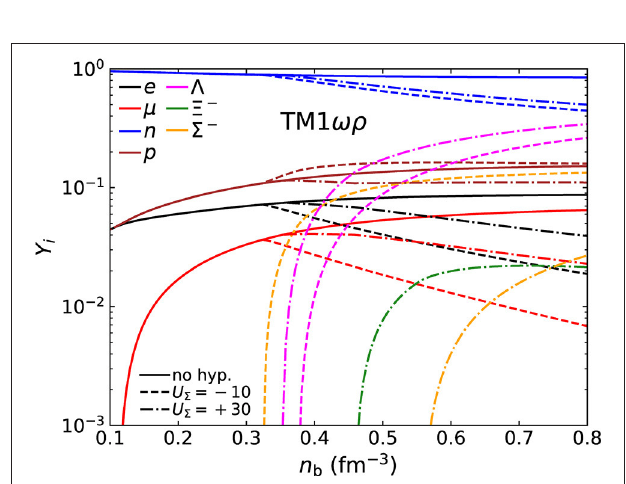
30 MeV (black lines with marks), = +